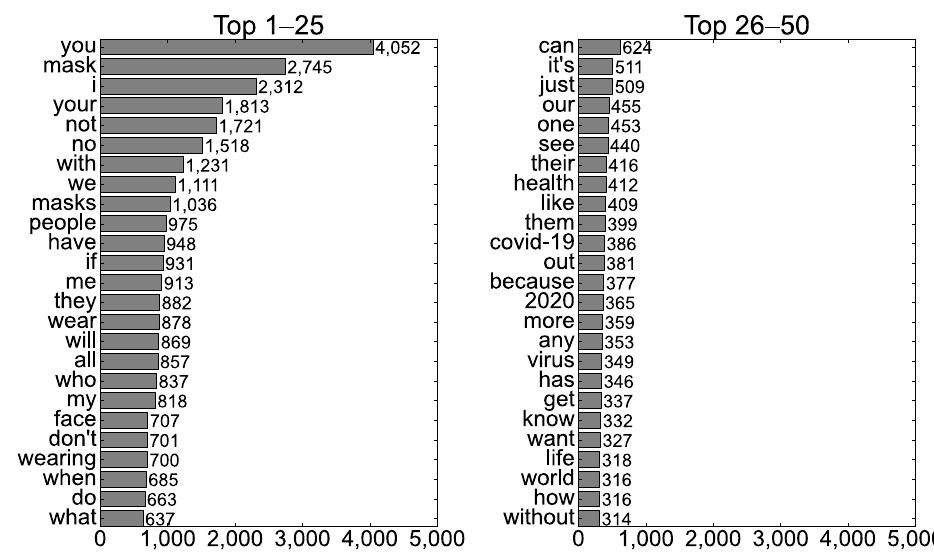
Figure 3. The 50 most frequent words presented in the Instagram photos with a #NoMask hashtag.